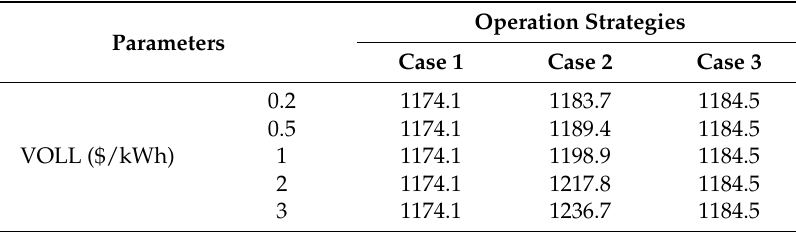
Table 3. Operating costs with different VOLLs.